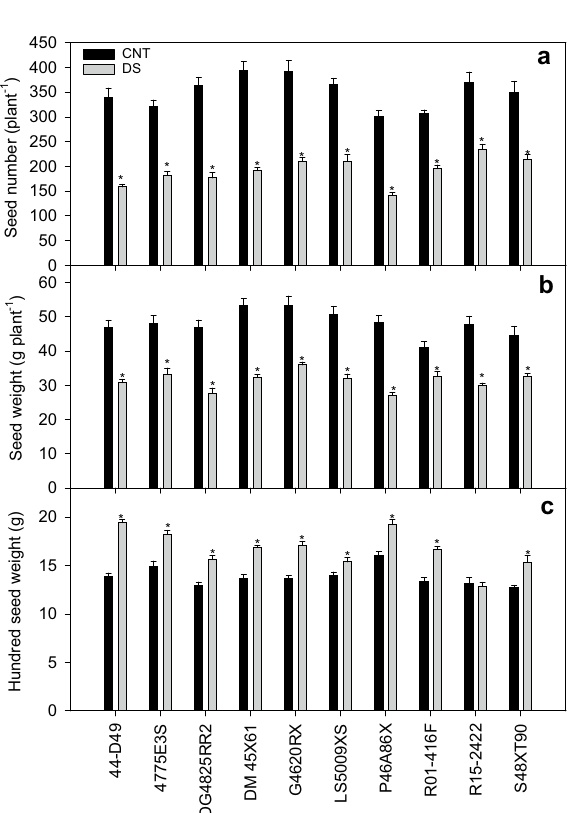
Figure 5. Seed number (plant −1 , a ) seed weight (g plant −1 , b ), and hundred seed weight ( g , c ) of ten soybean cultivars under control (CNT) and drought stress (DS). The vertical bars represent mean of 10 replicates ± SE. *indicates a significant difference between the CNT and DS for the given cultivar at p <